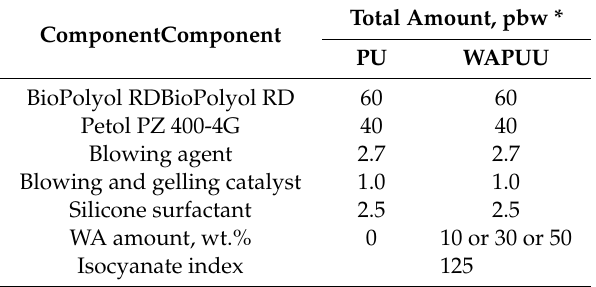
Table 1. Formulations of polyurethane (PU) and WA particles modified PU (WAPU) foams. Total Amount, pbw * ComponentComponent PU